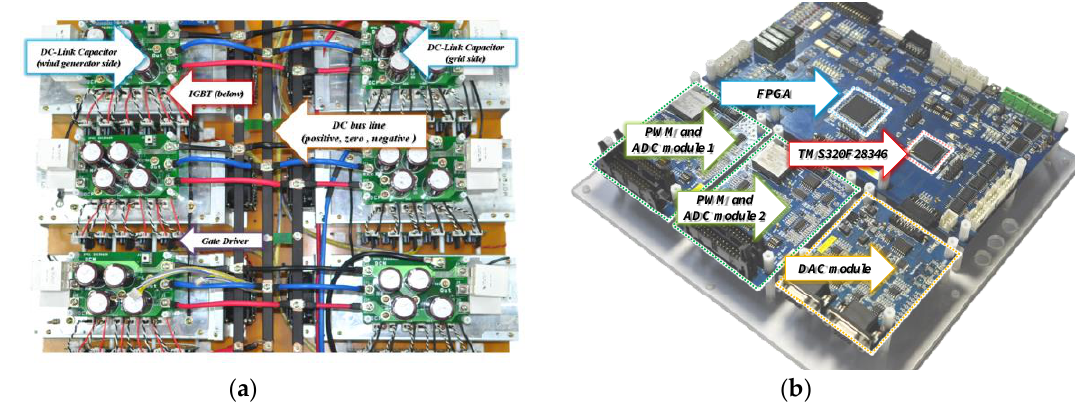
Figure 27. Configuration of the experimental setup: ( a ) The dc-link, switching devices, and gate driver; ( b ) The control board.